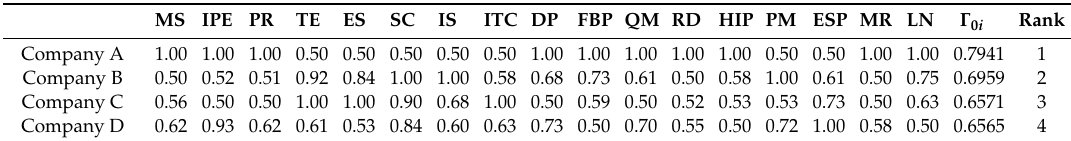
Table 4. Summaries of the resultant relational coe ffi